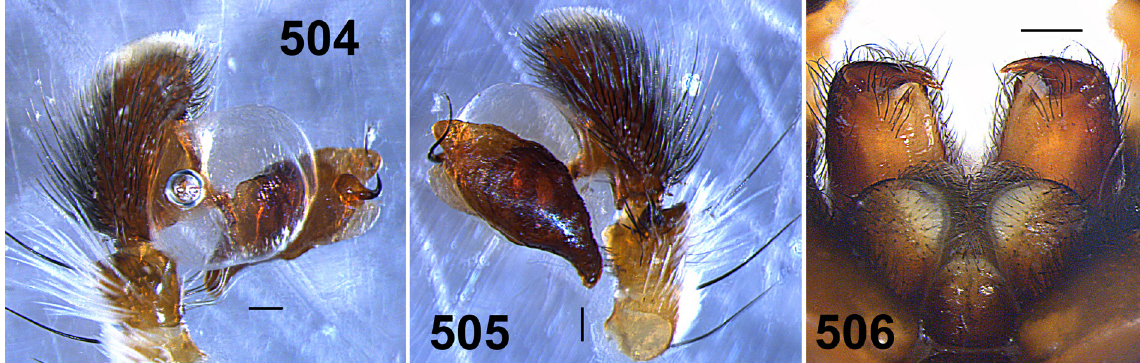
Figs 504–506. Phlegra davidi (Caleb, Mungkung & Mathai, 2015) comb. nov., ♂ from India (Tamil Nadu). 504 . Expanded palp, median view. 505 . Ditto, retrolateral view. 506 . Chelicerae, endites and labium, ventral view. Scale bars: 0.1 mm.